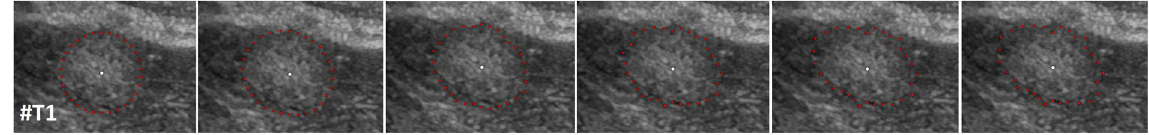
Figure 5. Segmentation results for different delta values: Δ r = 0 (leftmost) to Δ r = 5 (rightmost). Note, the user-defined seed point in white remains for all segmentations at the same position.